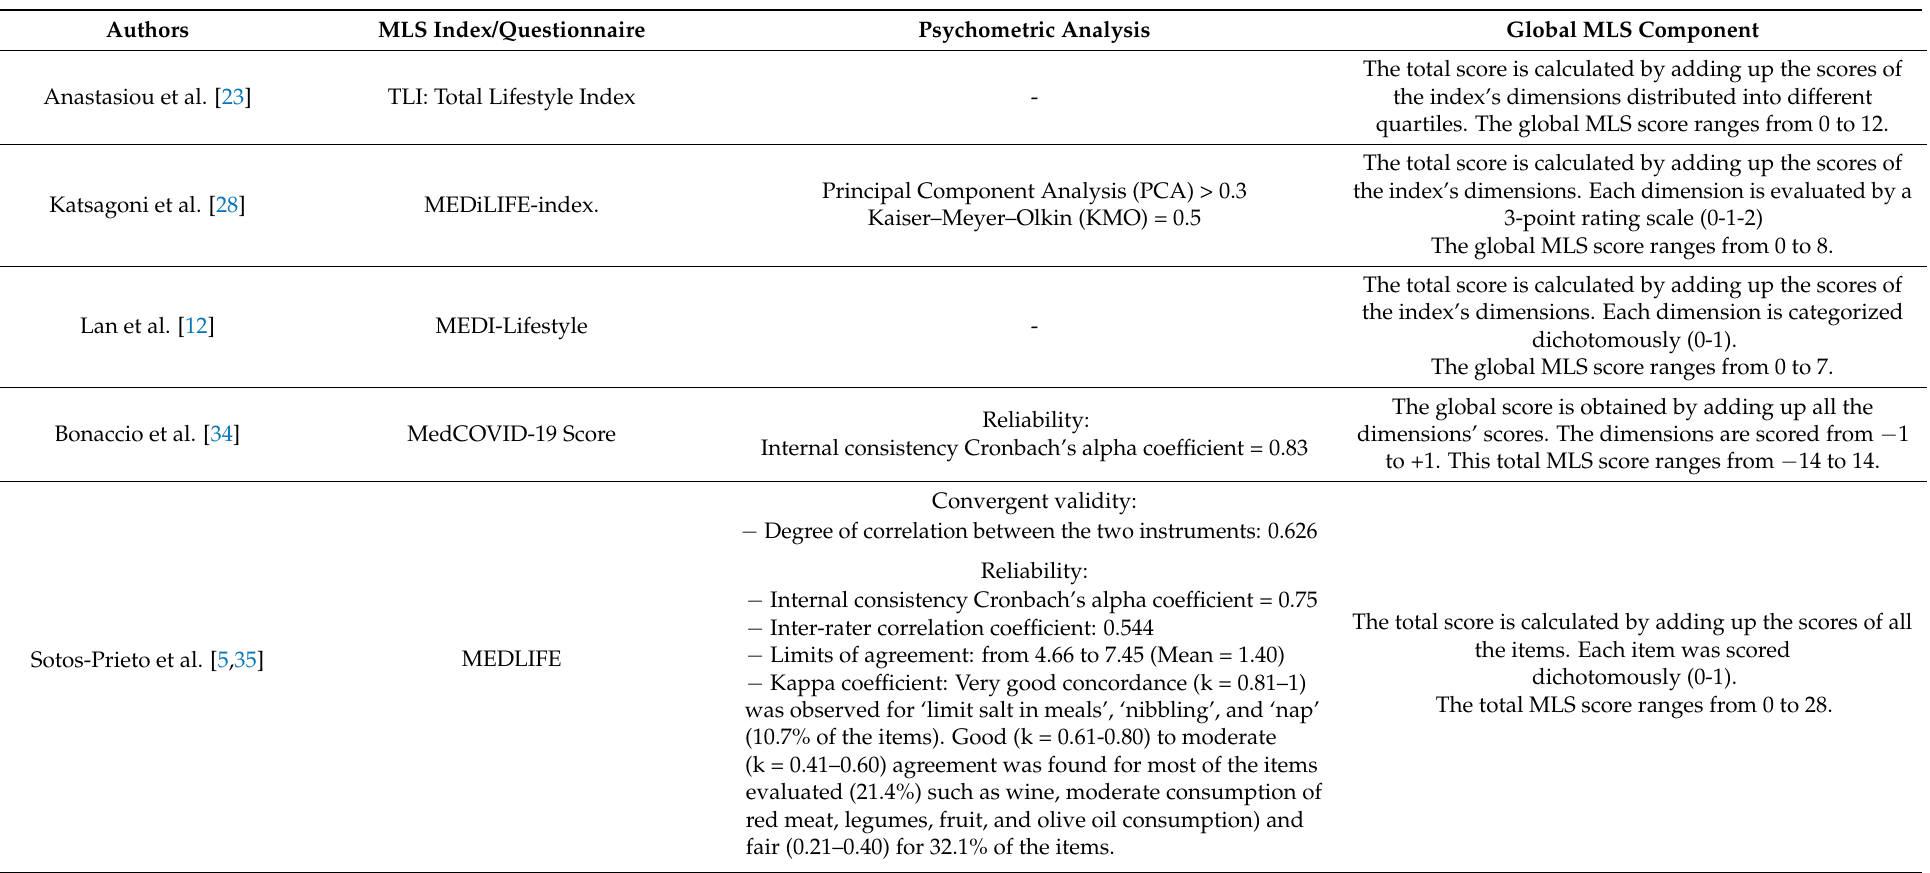
Table 6. Statistical analysis to create a Mediterranean Lifestyle score in the studies included in the review that have created an index or